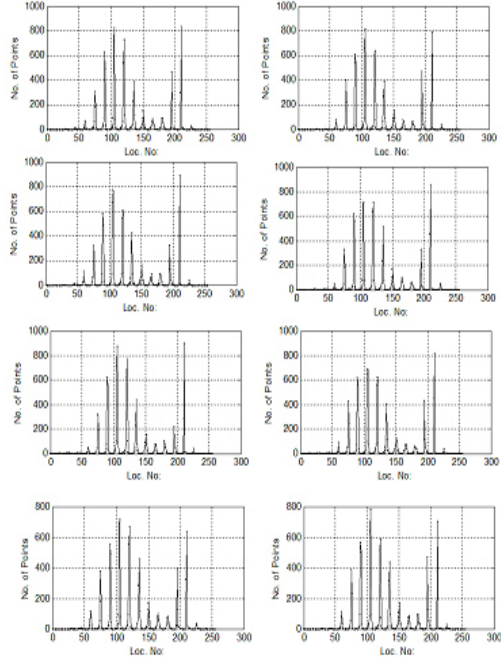
Fig. 9: State space map of first 8 persons’ face image in AT & T face database.